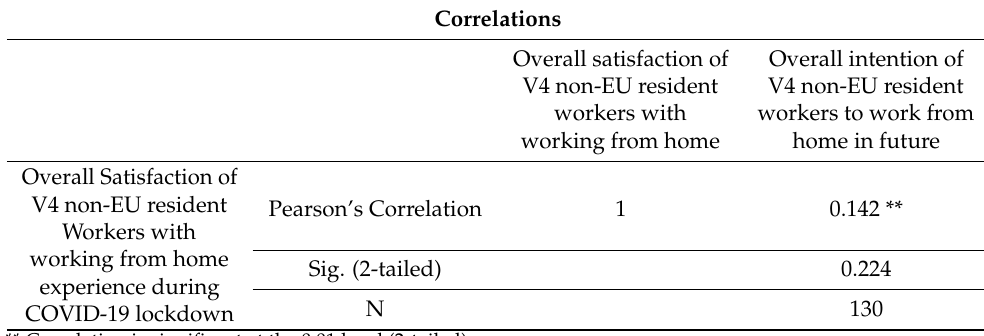
Table 8. Correlations between V4 non-EU resident workers overall satisfaction with working from home experience during COVID-19 lockdown and their intention to work from home in